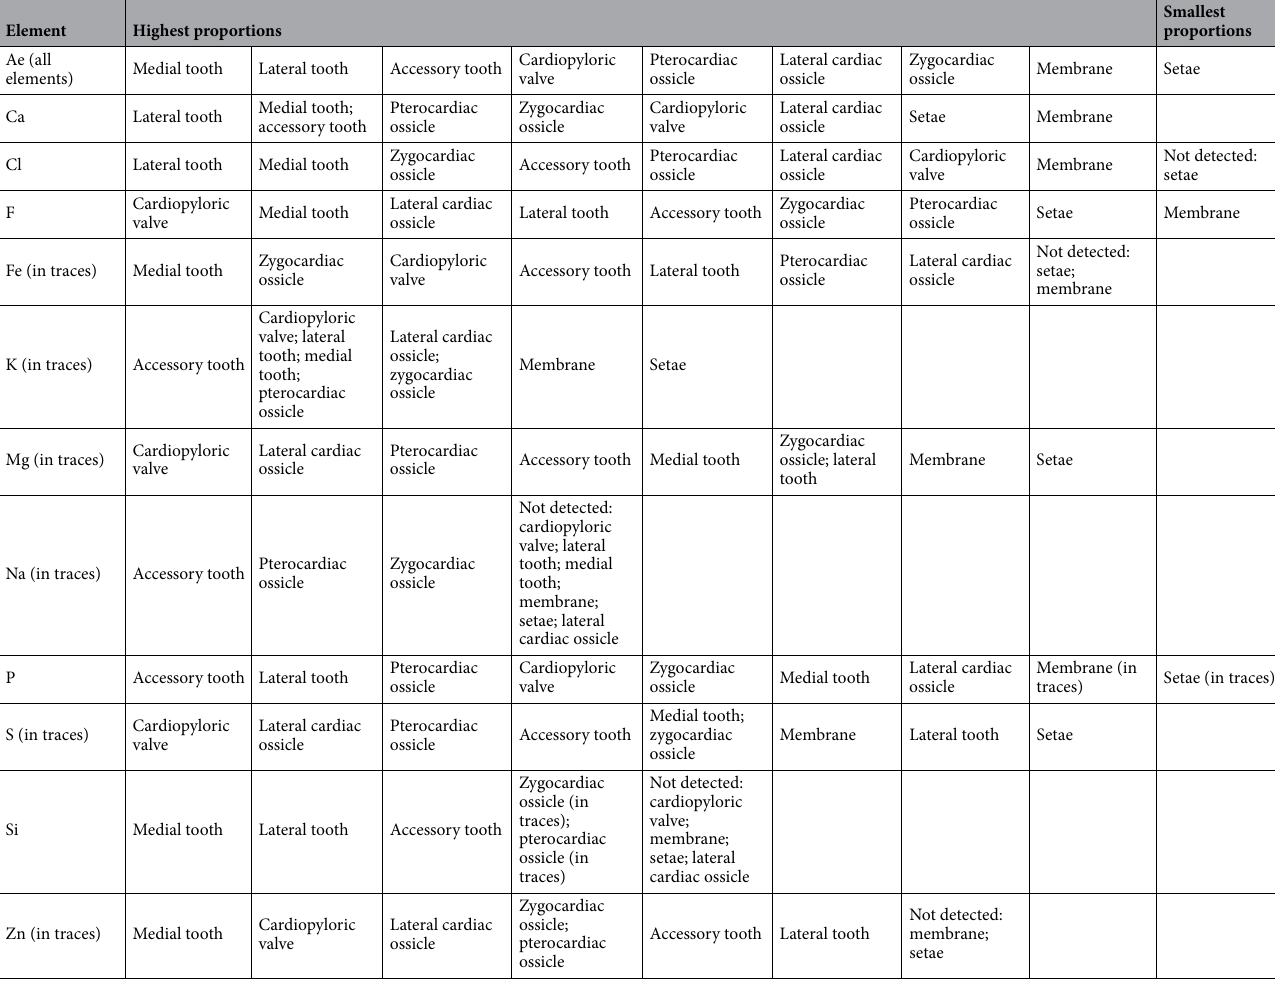
Table 3. Occurrence of all elements (Ae) and the individual elements in the studied structures. In each line, structures are ordered according to the proportions of the elements ( left side : highest proportion, right side : smallest